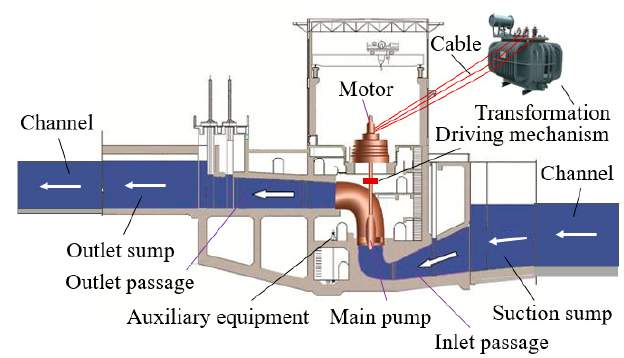
Figure 1. Components of a pumping station in an open-channel water transfer system.